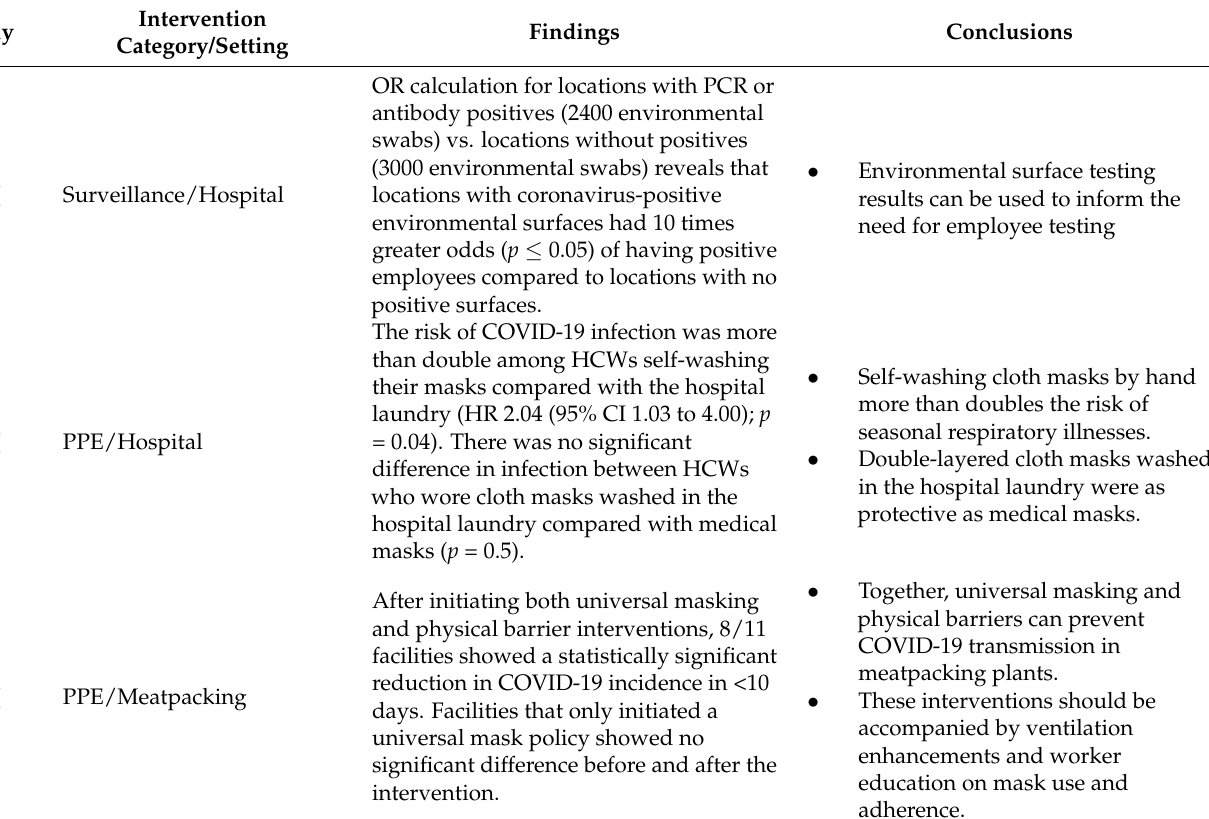
Table 10. Short description of the effectiveness of selected